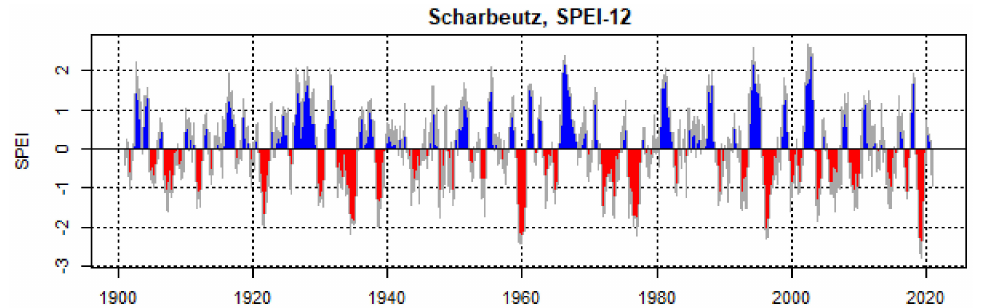
Figure 2. Calculated standardized precipitation evapotranspiration index (SPEI) for Scharbeutz from the year 1900 to 2020 with 12-month time scale. The blue-colored series represents positive SPEI values (>0) of years with a positive climatic water balance, and the red-colored series represents negative SPEI (<0) values of years with a negative climatic water